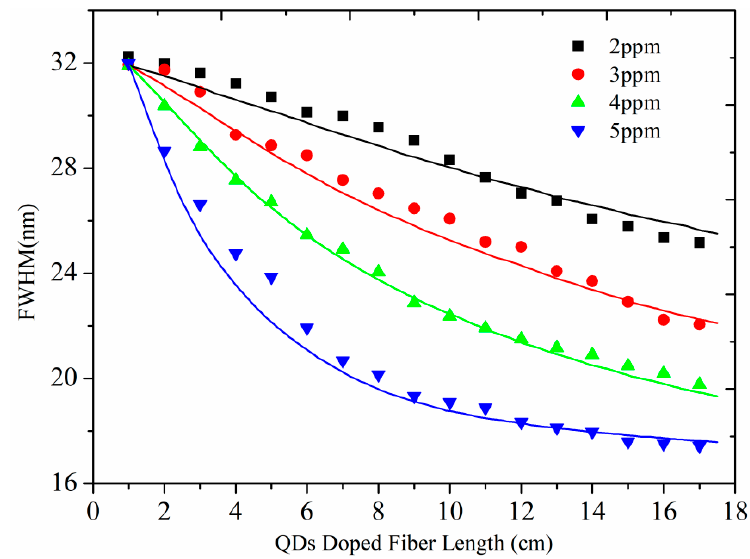
Figure 8. FWHM of the output SE spectra as a function of doped fiber length (the solid lines were the simulation results and the dots were the experimental results).